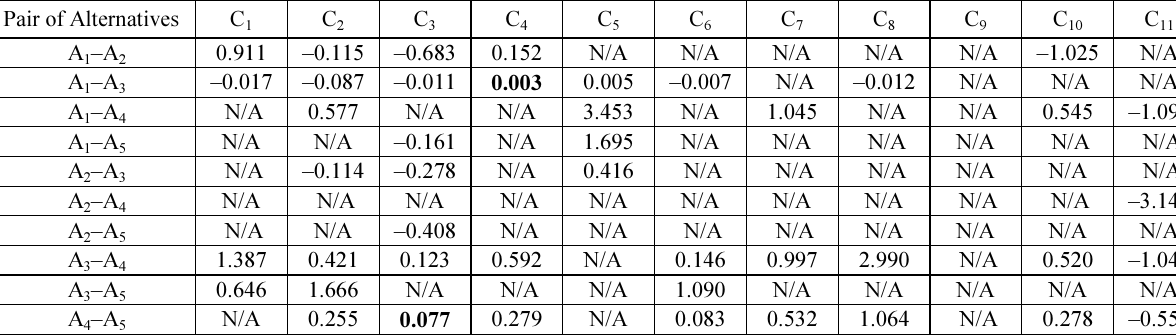
Table 10. All possible δ k,i,j values (absolute change in criteria weights) Pair of Alternatives